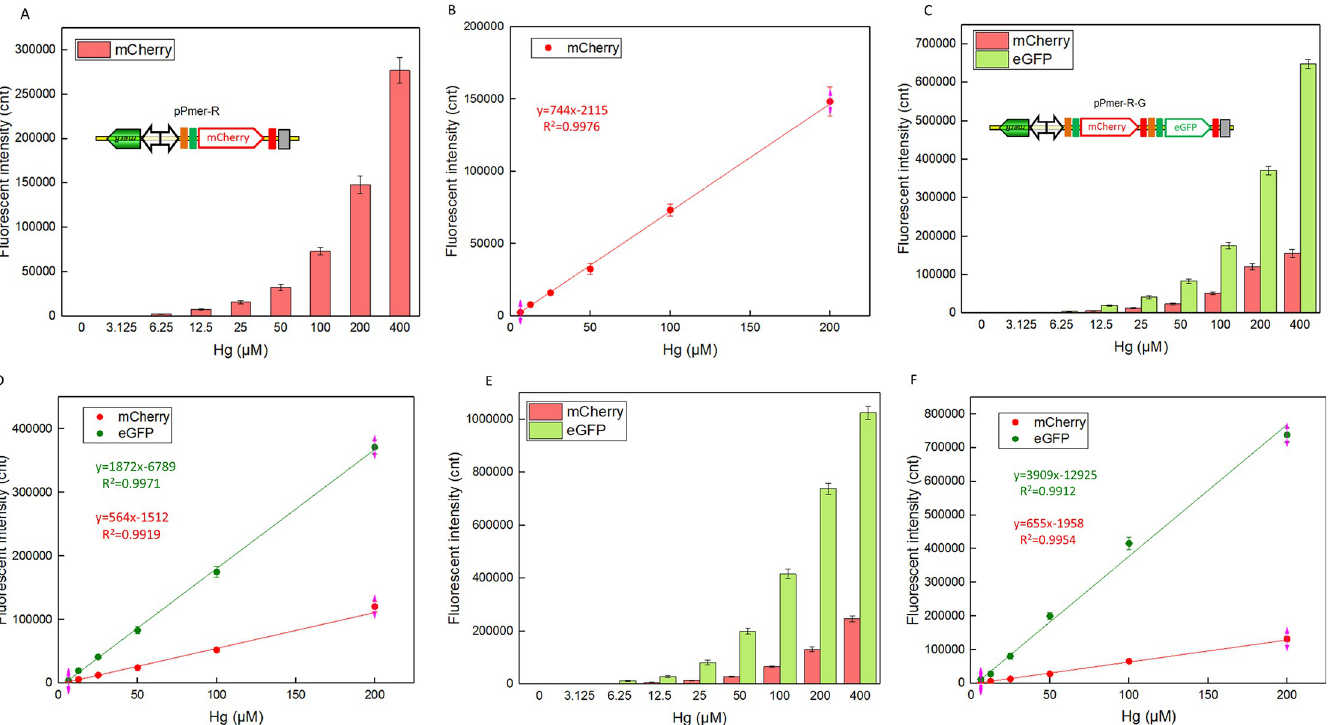
Fig 4. Comparison of reporter signals generated by three mercury biosensors after exposure to gradient concentrations of Hg(II). After induction with 0–400 μ M Hg(II) at 37˚C for 12 h, two kinds of fluorescent signals (mCherry and eGFP) were all determined. Whole-cell biosensor TOP10/pPmer-R dose-response (A) and linear response (B) to Hg(II), whole-cell biosensor TOP10/pPmer-R-G dose-response (C) and linear response (D) to Hg(II), and whole-cell biosensor TOP10/pPmer-R-Pmer- G dose-response (E) and linear response (F) to Hg(II). Fluorescence intensity values were normalized using the absorbance at 600 nm. The data were obtained by subtracting the value of recombinant E . coli with 0 μ M Hg(II) exposure from that of each group. Values represent the mean ± SD of at least three independent experiments.